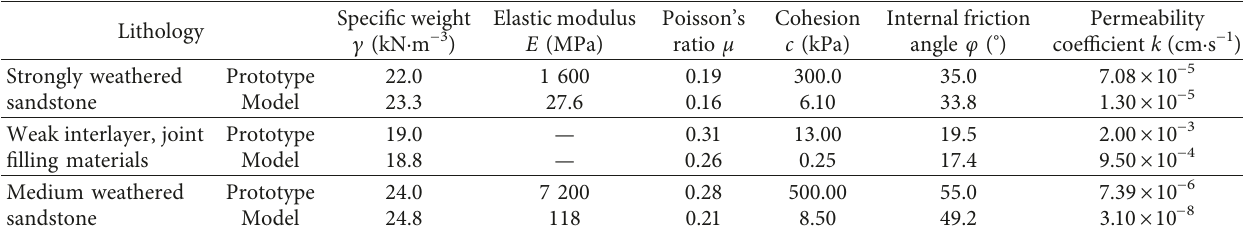
Figure 1: Profile of the bedded rock slope prototype. Table 1: Mechanical parameters of prototype and model slope materials.